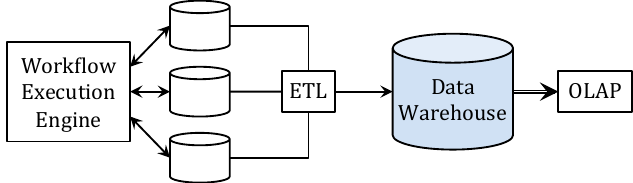
Figure 1. Traditional framework using extract, transform, load (ETL)/online analytic processing (OLAP).